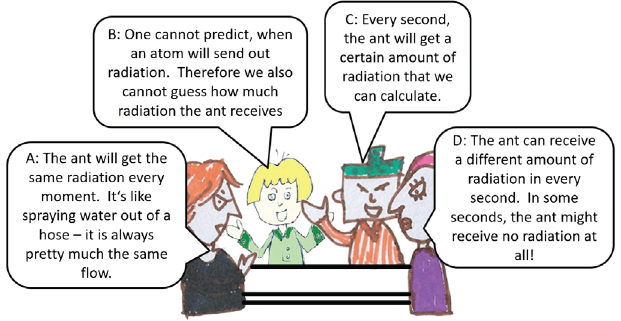
FIG. 1. The first prompt in SWORDE is ANT, where four students are discussing the radiation received by an ant standing beside a radioactive stone for 10 min, first where the stone contains “ a very small ” amount of radioactive substance (ANT: TRACE) and then when the stone contains “ a huge amount ”